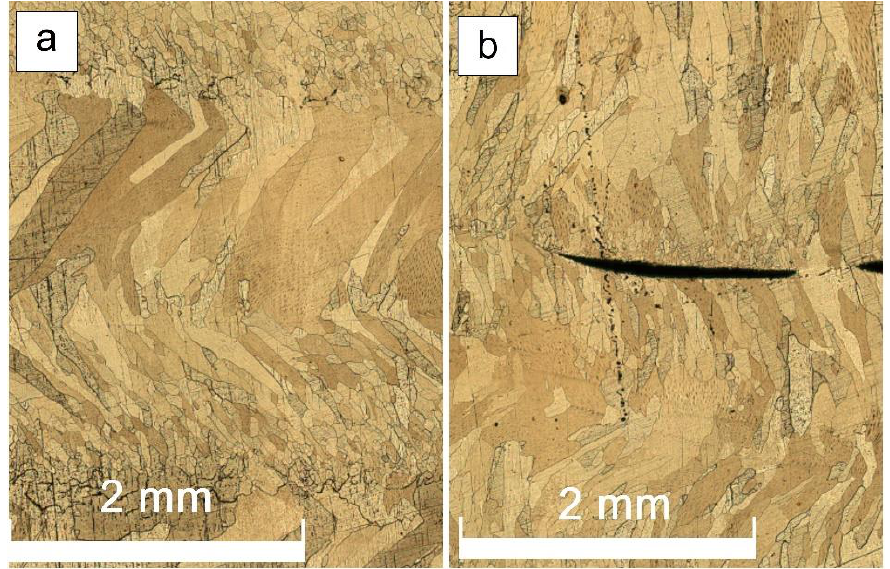
Figure 4. Equiaxed and columnar grain structures ( a ), fusion discontinuities ( b ) in the wall obtained at heat input of 0.21 kJ/mm.